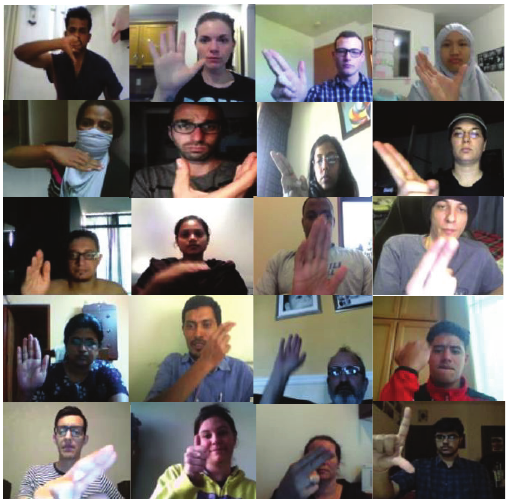
Figure 9. Part of the Jester dataset.